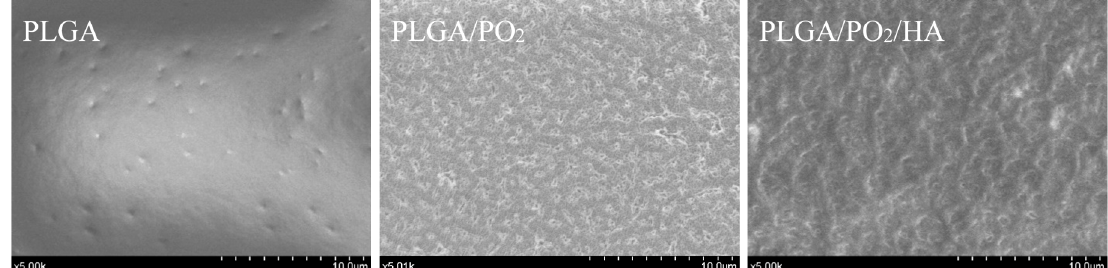
Figure 4. Scanning Electron Microscopy ( SEM) images of the three steps of the membrane modification